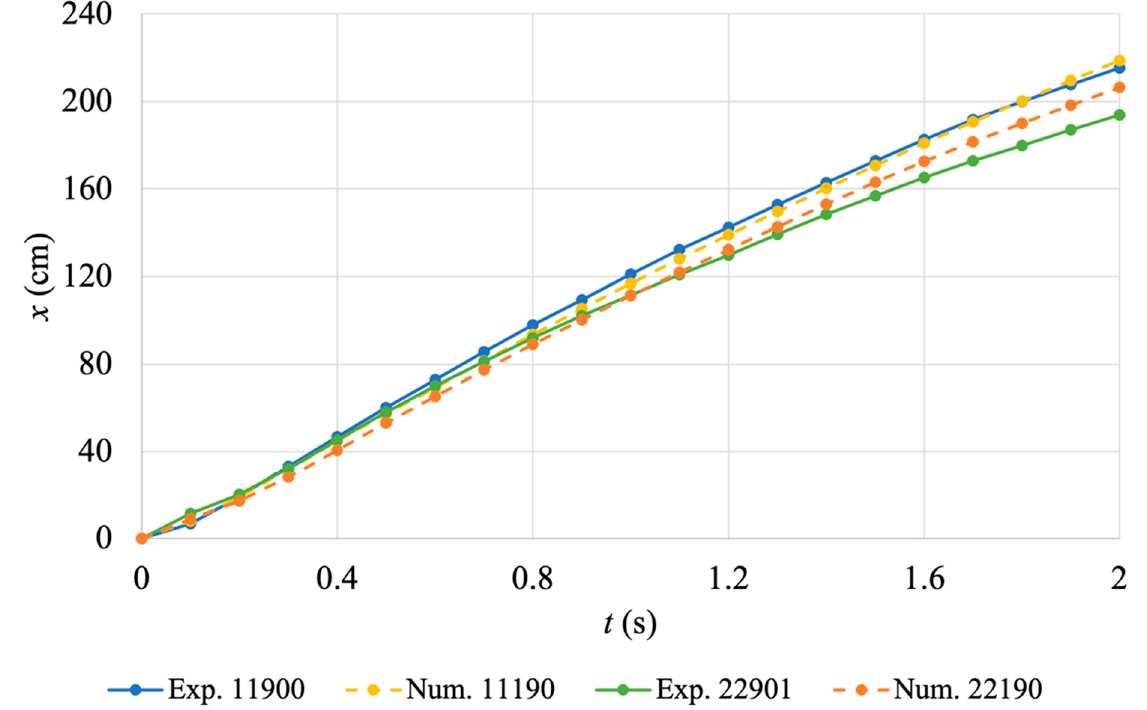
Figure 10 . Comparison between the output value (center-of-gravity position of the FS3M numerical simulation in x -direction) and the position of the center of gravity of the container in the x direction obtained from Tomita et al. [18] for Configuration 11190 (Configuration 11900 in hydraulic experiment) and Configuration 22190 (Configuration 22901 in hydraulic experiment). Here, t refers to the time matched at the beginning of the container motion.